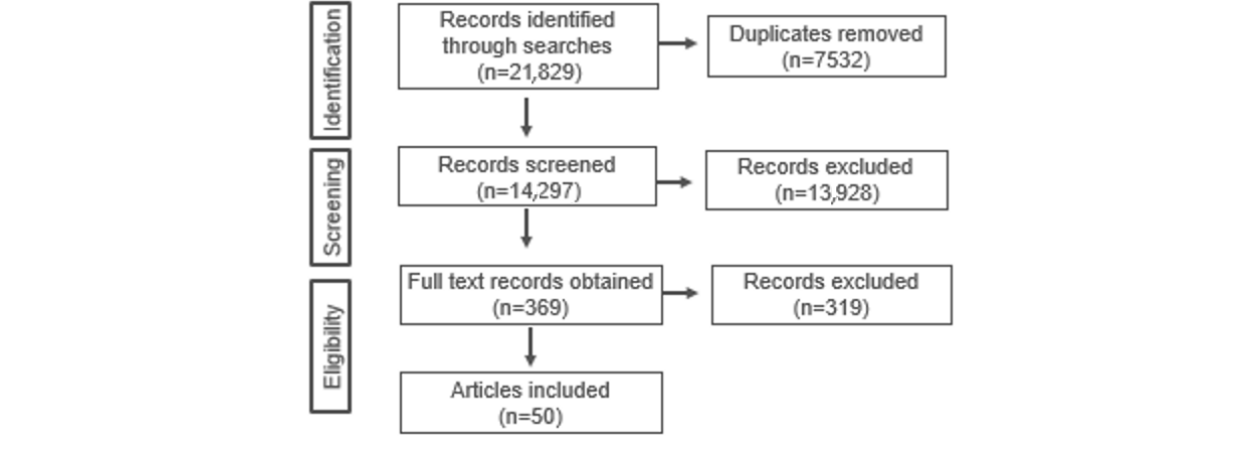
Figure 1. Flow chart of the search results and screening